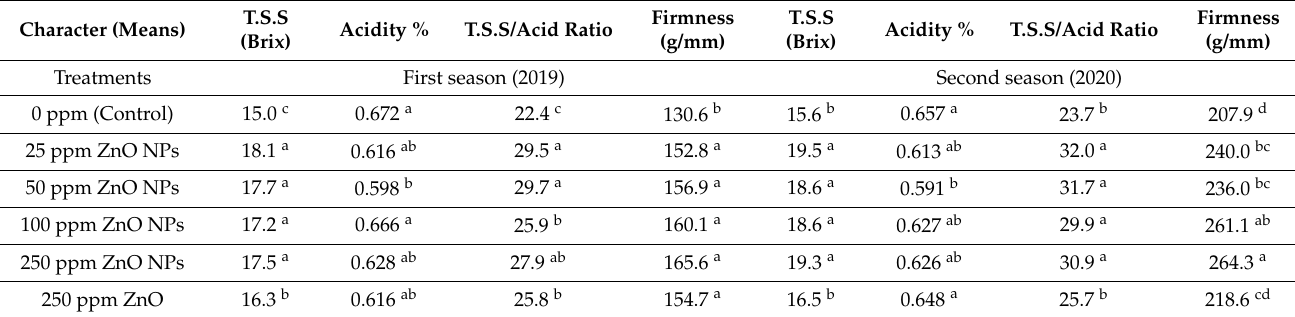
Figure 2. Characterization of ZnO nanoparticles. ( A ): SEM image shows spherical nanoscale (80–130 nm) particles. ( B ): XRD pattern showing the c phase patten of ZnO crystal. Table 1. Effect of foliar spraying of ZnO NPs on some physiochemical fruit properties of Crimson seedless grape cultivar during two seasons (2019 and